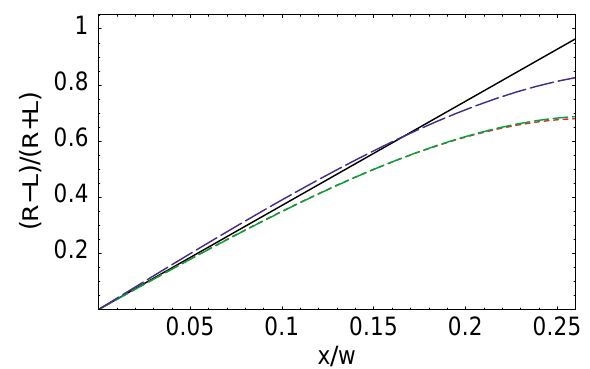
FIG. 8. (Color) Same as Fig. 6, but with s x (cid:1) 0 , s y (cid:2) h (cid:1) 0.1 .